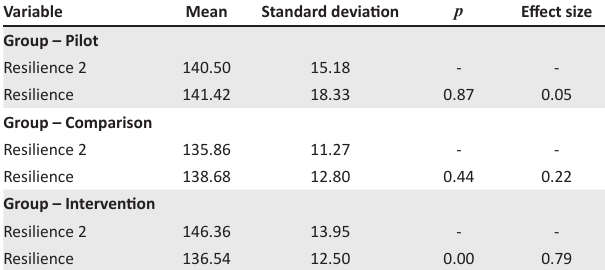
TABLE 4: Dependent t -test in each group on increase in resilience.